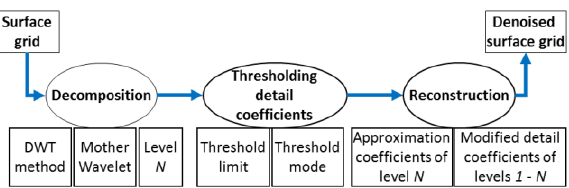
Figure 1. General DWT denoising